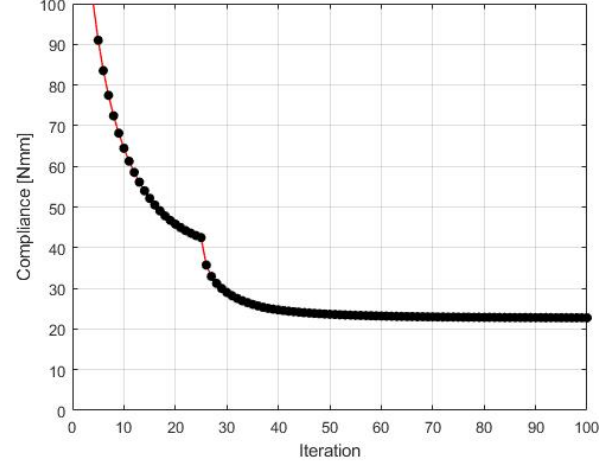
Figure 20. The compliance history for the test structure 4. Minimal value: 22.71 Nmm. Black dots on the red line represent the compliance values for subsequent iterations.